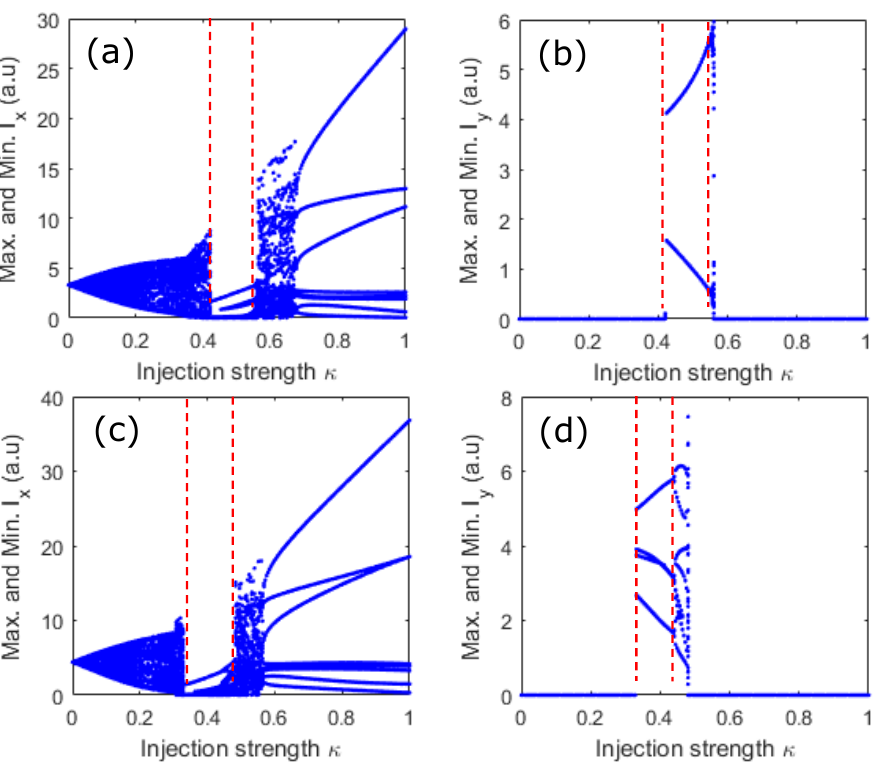
Figure 11. Bifurcation diagrams for fixed injected comb spacing Ω = 2 GHz and γ a = − 0.8 ns − 1 . The left and right panels correspond to X-PM and Y-PM, respectively. ( a , b ) are obtained for µ = 4.2 and ( c , d ) for µ =